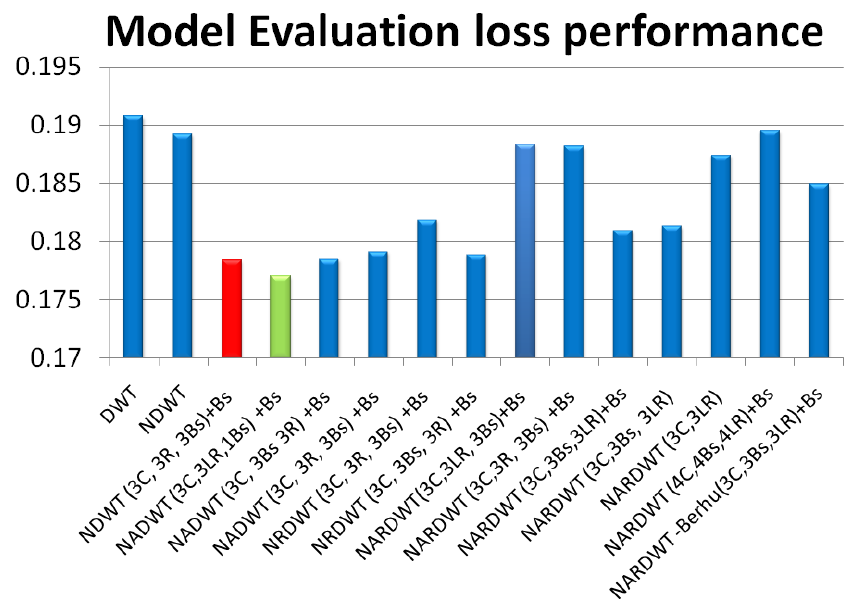
Figure 12. Model loss performance. The best is DWT + Attention followed by Residual + Attention architecture.